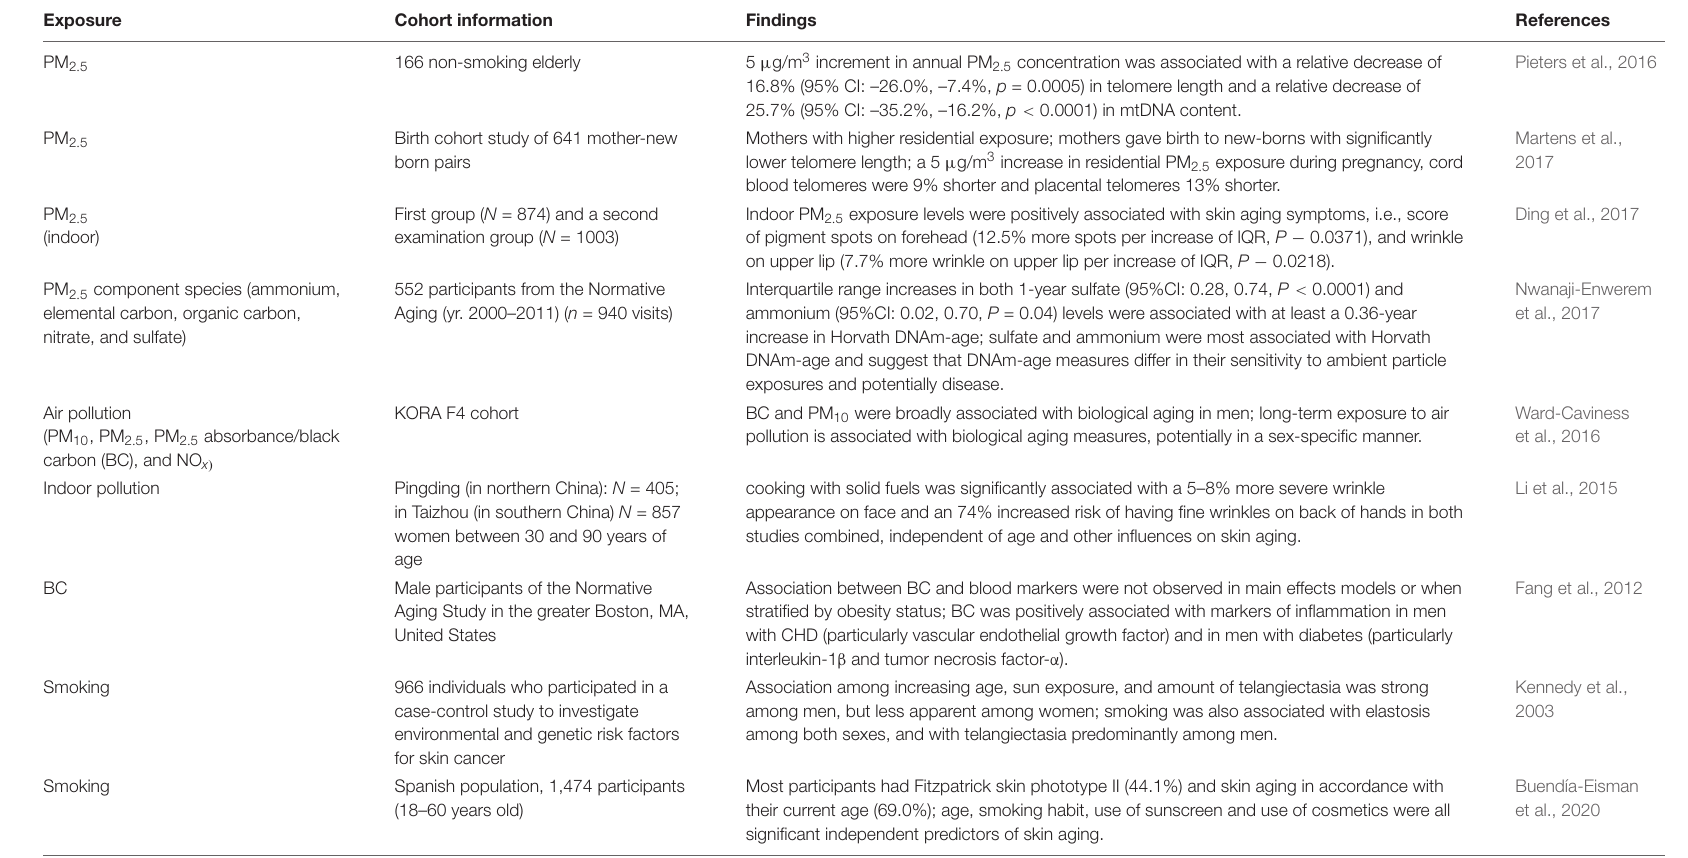
TABLE 1 | List of studies that looked at exposure and its effect on aging in human studies. Exposure Cohort information